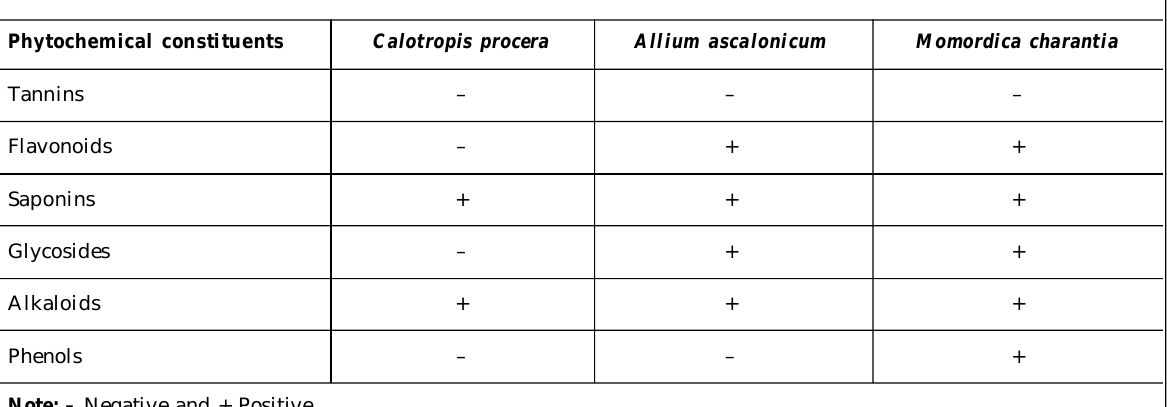
Table 1: Phytochemical screening of Calotropis procera, Momordica chaxrantia, Allium ascalonicum